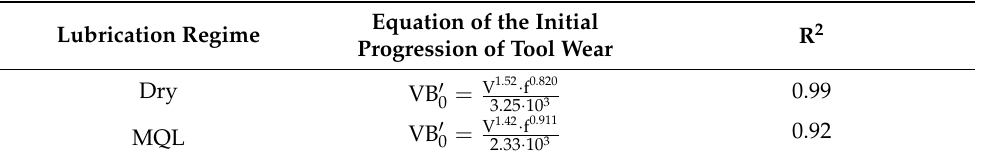
Table 3. Models of the initial progression of the tool wear. MQL: Minimum Quantity Lubrication. VB’ 0 : initial wear